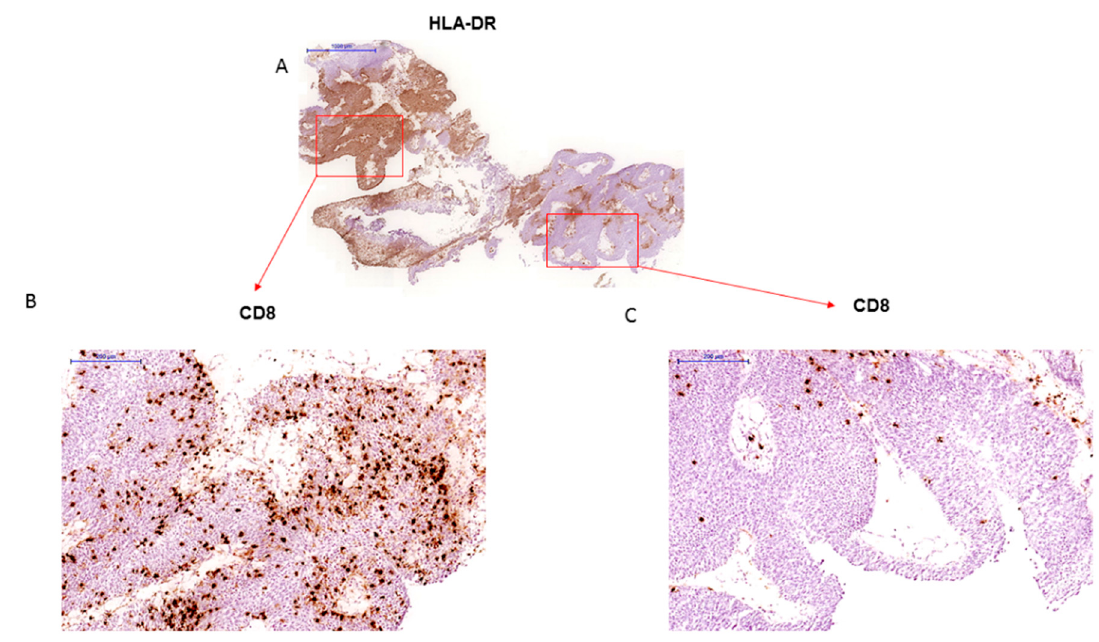
Figure 2. ( A ) Bladder tumor sample with heterogeneous pattern of HLA-DR immunostaining (20 × magnification) ( B ) HLA-DR positive area is heavily infiltrated with CD8+ T-cells (“inflamed” tumor), while HLA-DR negative distal zone is significantly less infiltrated with more lymphocytes in the stroma at the tumor margin ( C ) (A and C–at a 100 × magnification). Table 3. Phenotypic characteristics and pattern of T cell infiltration in HLA class II positive tumors.